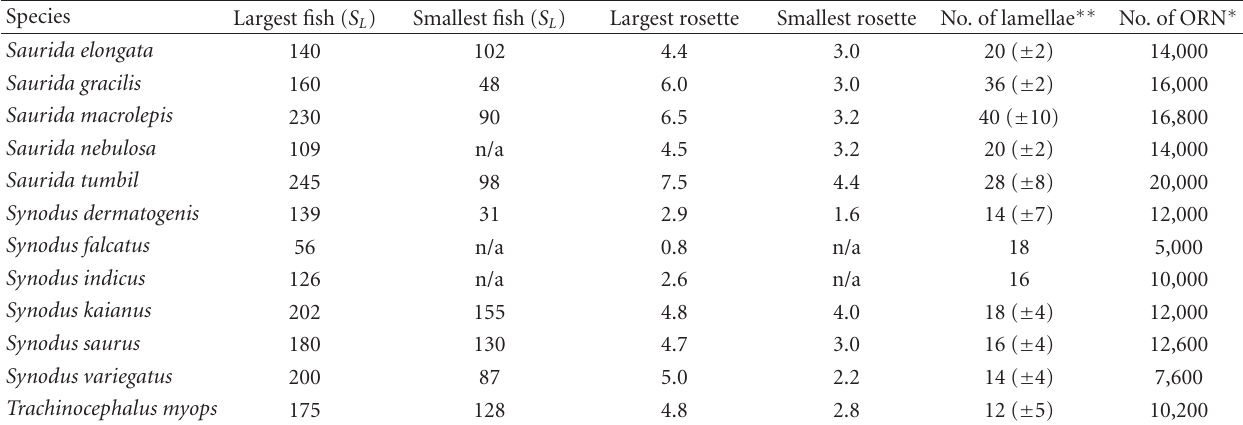
Table 2: Dimensions of rosettes, number of lamellae, and approximate number of ORN on the largest of them (size inmm) in the studied